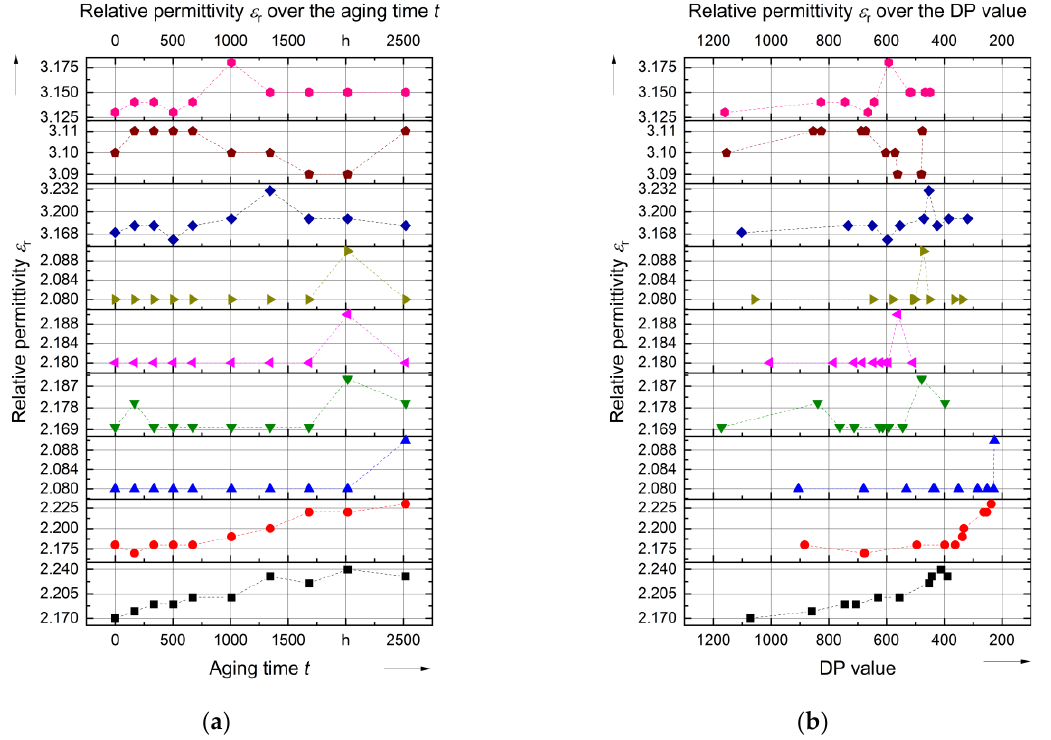
Figure 11. Change of relative permittivity ε r at 25 °C for different sealing systems and fluids: ( a ) Change over the aging time; ( b ) Change over the DP value; the legends refer to Figure 6a.